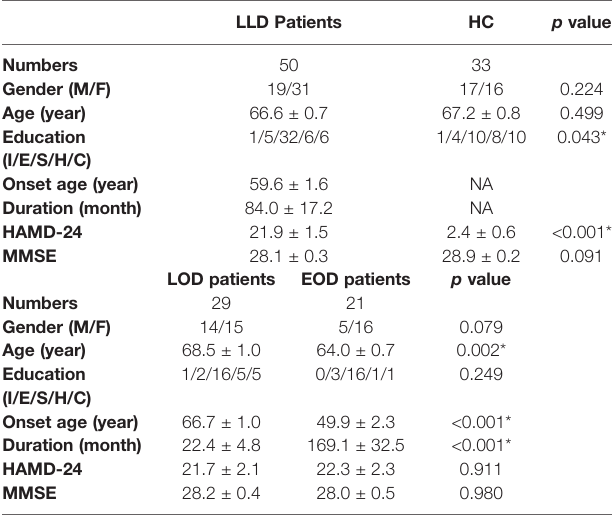
TABLE 1 | Demographics and clinical assessment of the